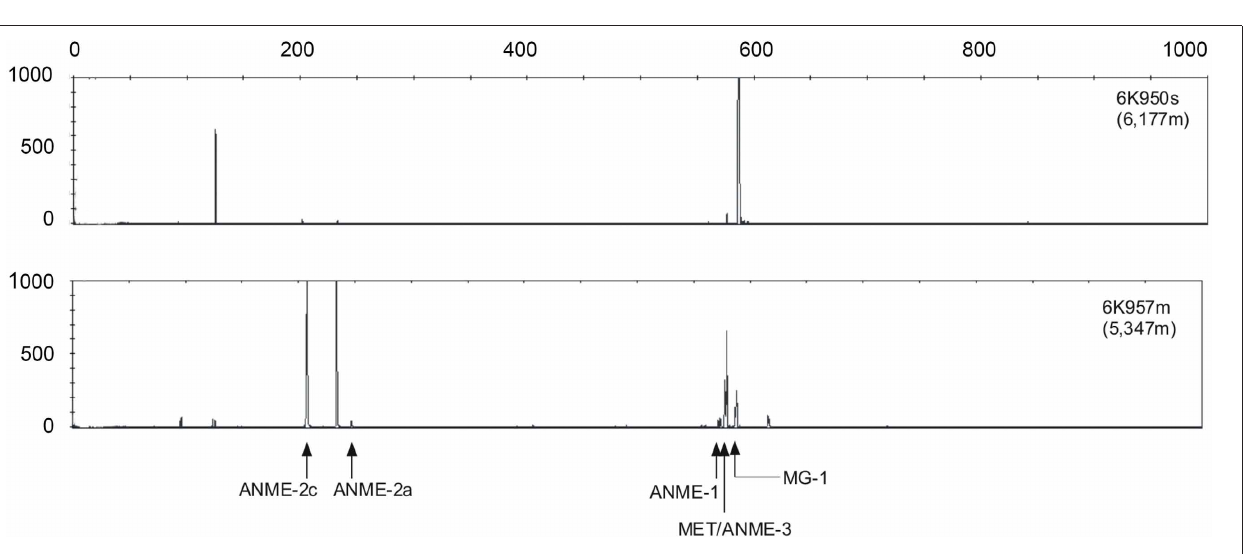
euryarchaeota group, and the anoxic methane oxidizing archaea group, respectively. The lengths of the fragments are displayed on the x-axis and relative fluorescence intensity of peaks is shown on the